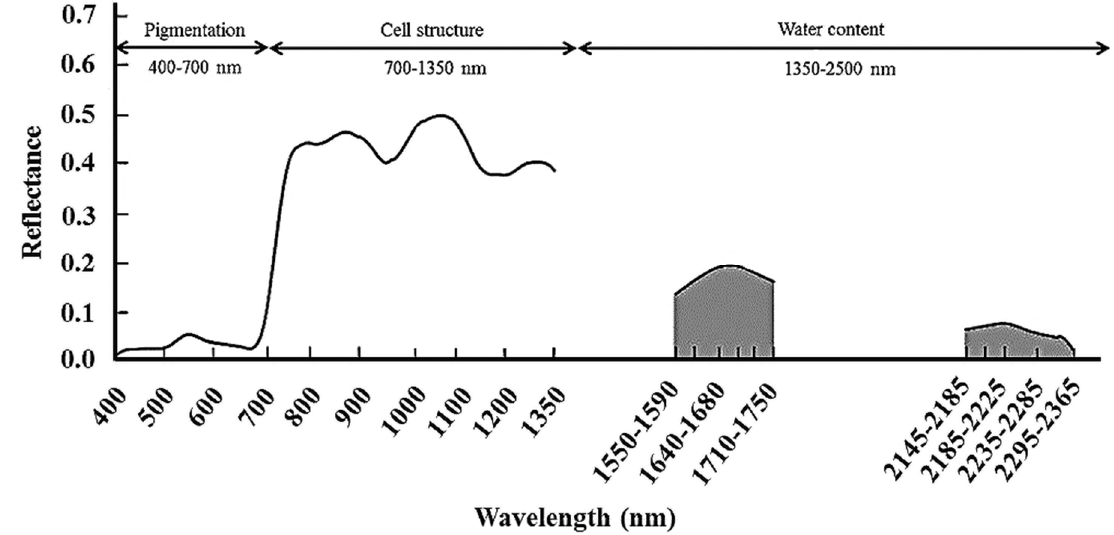
Figure 1. Reflectance of a Conference pear tree. The shaded area indicates the SWIR regions used in this study. The shaded areas of 1550–1750 nm were segmented into three, 40-nm regions and integrated into one 200-nm region. The area of 2145–2365 nm was segmented into two 40-, one 50- and one 70-nm region,